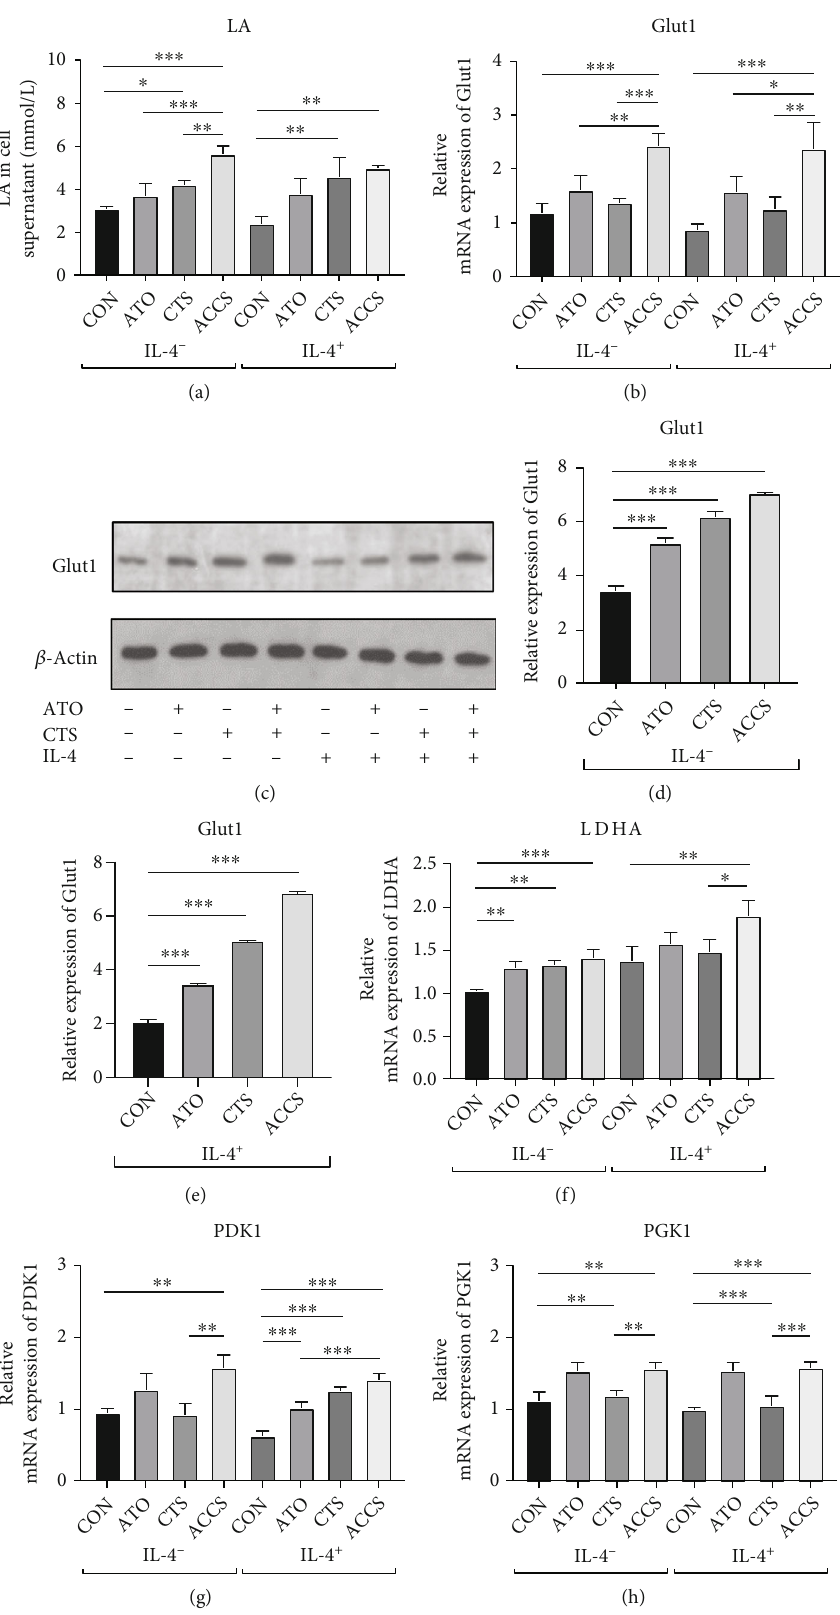
Figure 6: Regulation of glycolysis in primary macrophages by ACCS intervention. (a) Levels of LA in the cell supernatant. (b) Levels of Glut1 gene expression. (c – e) Levels of Glut1 protein expression. (f – h) Gene expression levels of key rate-limiting enzymes in glycolytic